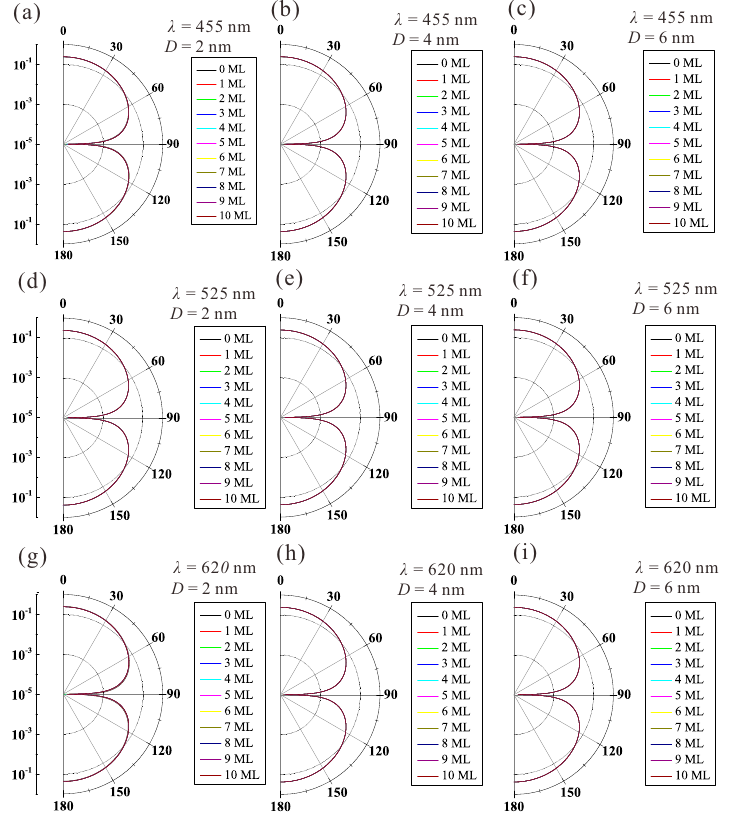
Figure 4. Scattering phase distributions of quantum-dot-converted elements (QDCEs) with varying diameter, D , and number of molecule layers (MLs) of CdSe/ZnS quantum dots (QDs). λ : wavelength of incident light.